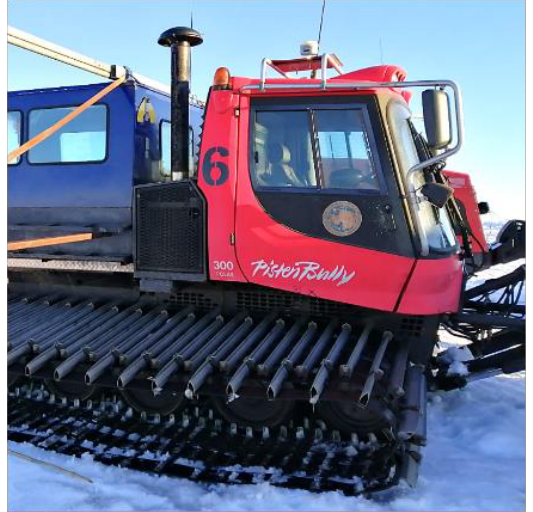
Figure 1. GNSS roving receivers mounted on the roof of a Pisten Bully snowcat and for ice surface elevation estimation from the GNSS